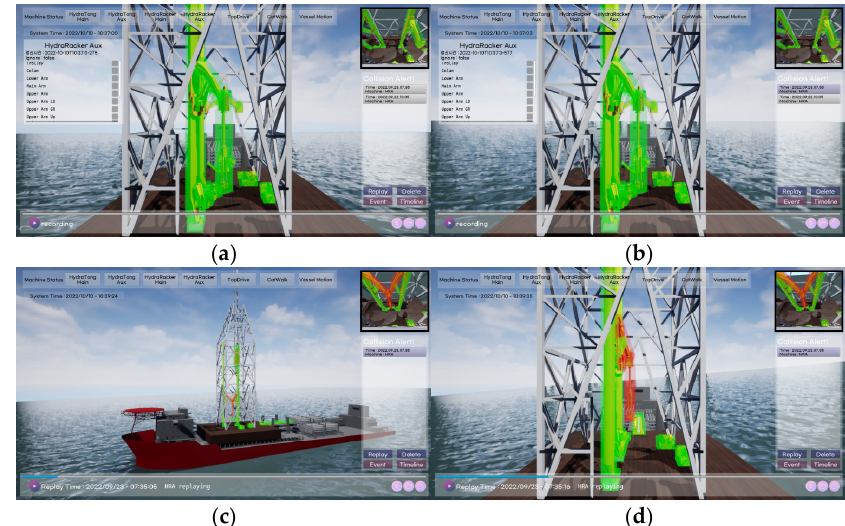
Figure 10. Collision alert bar is activated. ( a ) Collision history is shown in the collision alert box.